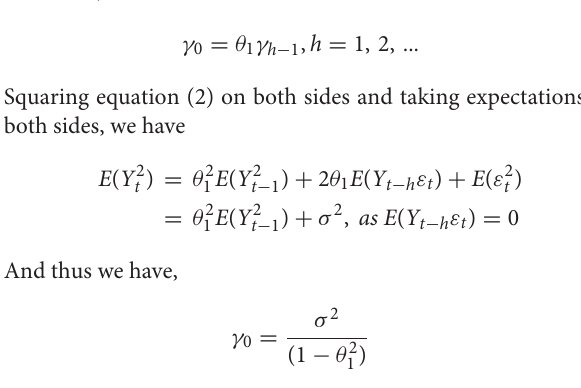
The time series { Y t } is called stationary of order two if E ( Y t ) =